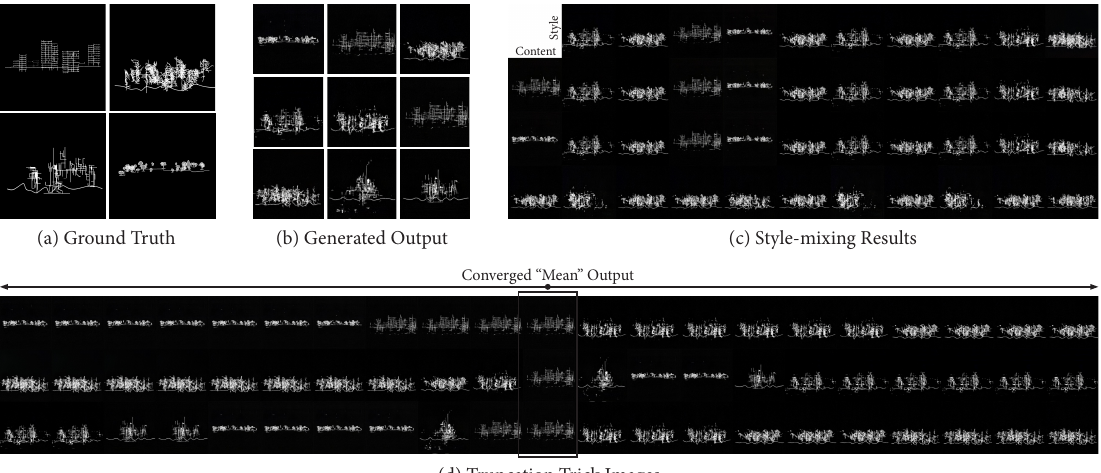
Figure 8. These are the training processes and results of multiple-style drawings: ( a ) Example of input data. ( b ) Selected output fake images. ( c ) Contents, styles, and mixed results. ( d ) Continuing transforming images stack.